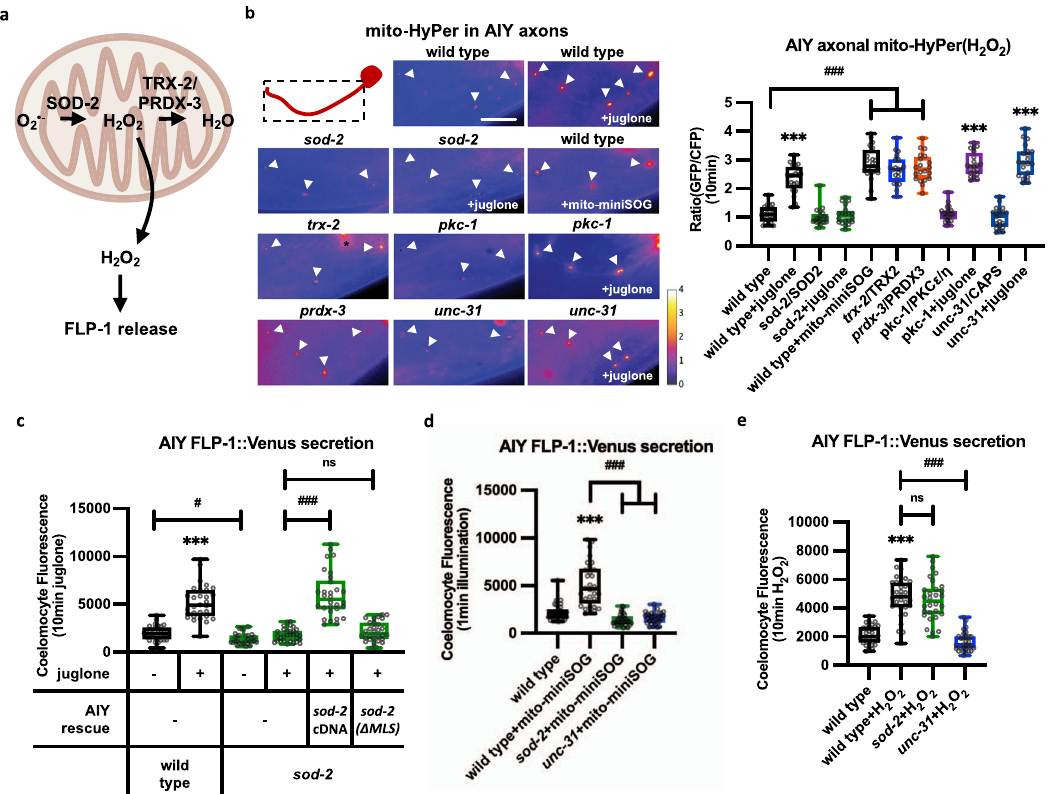
Fig. 4 FLP-1 secretion from AIY interneurons relies on mitochondria-generated H 2 O 2 . a Schematic representation of the generation of mitochondrial hydrogen peroxide (mtH 2 O 2 ) by dismutation of superoxide (O 2 − ) by mitochondrial SOD-2/superoxide dismutase, and its consumption by the mitochondrial TRX-2/thioredoxin PRDX-3/peroxiredoxin system, which converts mtH 2 O 2 to H 2 O. b Representative images and quanti fi cation of fl uorescence in AIY axons of the indicated transgenic animals expressing mitochondrial-targeted HyPer (mito-HyPer) driven by ttx-3 promoter. Arrowheads indicate mitochondrial fl uorescence in AIY axons. The 520 nm/480 nm (GFP/CFP) ratio of HyPer was used to measure mtH 2 O 2 levels. The boxes span the interquartile range, median is marked by the line and whiskers indicate the minimum and the maximum values. n = 20 biologically independent samples. *** P < 0.001 by Student ’ s two-tailed t -test. ### P < 0.001 by one-way ANOVA with Dunnett ’ s test. Scale bar: 10 μ m. c Quanti fi cation of average coelomocyte fl uorescence of the indicated mutants expressing FLP-1::Venus fusion proteins in AIY following vehicle (DMSO) or juglone treatment for 10 min. AIY rescue denotes expression of the indicated sod-2 cDNAs under control of the ttx-3 promoter. sod-2 ( Δ MLS) denotes sod-2 cDNA in which the mitochondrial localization sequence has been removed. The boxes span the interquartile range, median is marked by the line and whiskers indicate the minimum and the maximum values. n = 30 biologically independent samples. *** P < 0.001 by Student ’ s two-tailed t -test. # P < 0.05, ### P < 0.001, n.s not signi fi cant by one-way ANOVA with Dunnett ’ s test. d Quanti fi cation of average coelomocyte fl uorescence of the indicated mutants co- expressing FLP-1::Venus and mito-miniSOG in AIY following 1 min illumination with 50 mW/cm 2 blue light and 10 min recovery. The boxes span the interquartile range, median is marked by the line and whiskers indicate the minimum and the maximum values. n = 30 biologically independent samples. the indicated mutants expressing FLP-1::Venus fusion proteins in AIY following 10 min vehicle (M9) or H 2 O 2 treatment. H 2 O 2 treatment increased FLP-1 secretion in wild-type, sod-2 and ric-7 mutants, but not in unc-31 mutants. The boxes span the interquartile range, median is marked by the line and whiskers indicate the minimum and the maximum values. n = 30 biologically independent samples. *** P < 0.001 by Student ’ s two-tailed t -test. ### P < 0.001, n.s not signi fi cant by one-way ANOVA with Dunnett ’ s